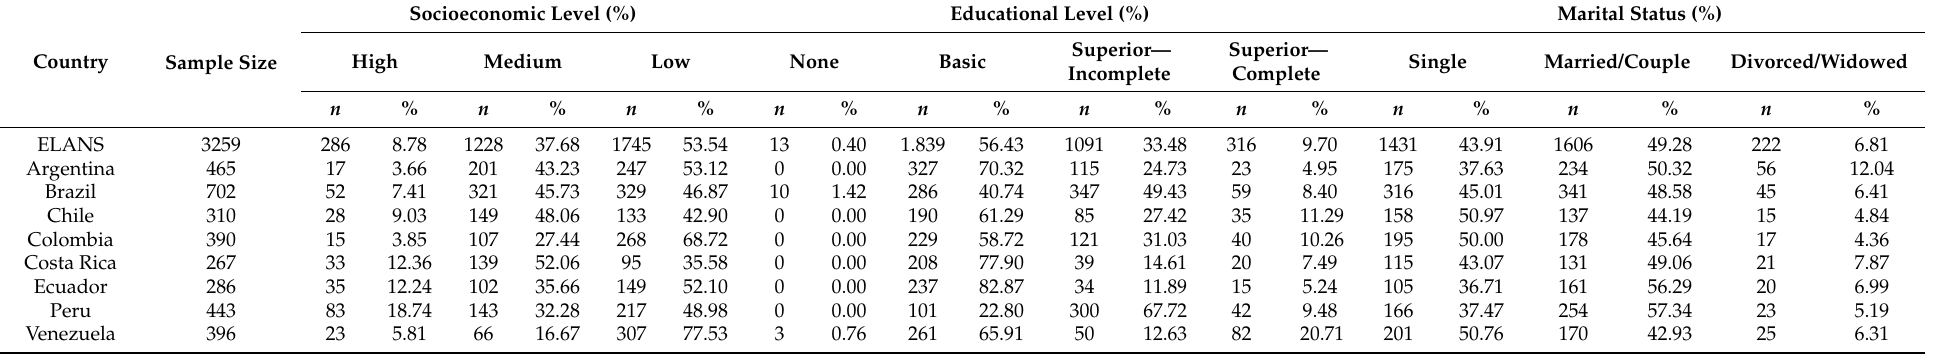
Table 1. Sociodemographic characteristics by age group and country among childbearing-age women in the Latin American Study of Nutrition and Health (ELANS), 2015.